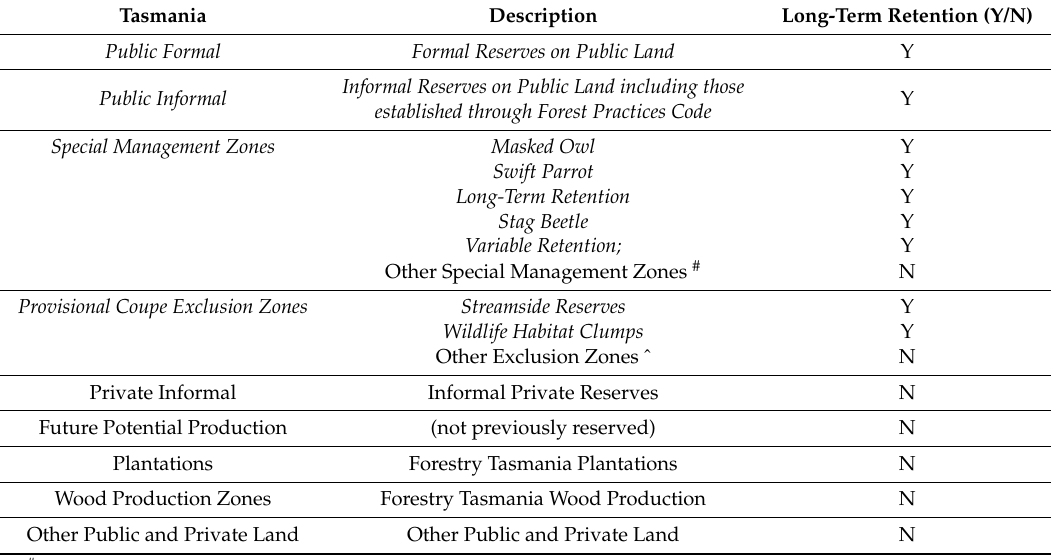
Table A1. Tenure types in public native forest in Tasmania. Categories included in long-term retention are highlighted in italics. Adapted from Landscape Conservation Planning System [39] and based on spatial data from the Management Decision Classification [88] and other spatial layers of tenure (i.e., Tenplus and Provcoupe exclusion codes).